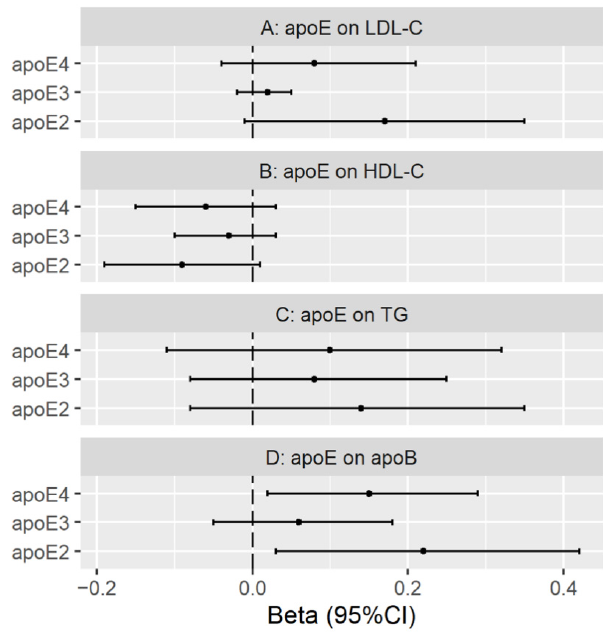
Figure 3. Univariable MR estimates for plasma apolipoprotein E2 (apoE2), apolipoprotein E3 (apoE3) and apolipoprotein E4 (apoE4) on low-density lipoprotein cholesterol (LDL-C), high-density lipoprotein cholesterol (HDL-C), triglycerides (TG) and apolipoprotein B (apoB) using inverse variance weighting with genetic predictors from the KORA study.